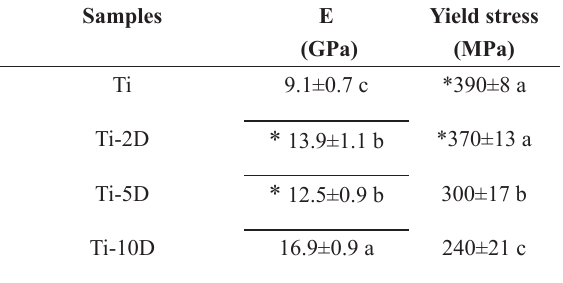
Results obtained from compression